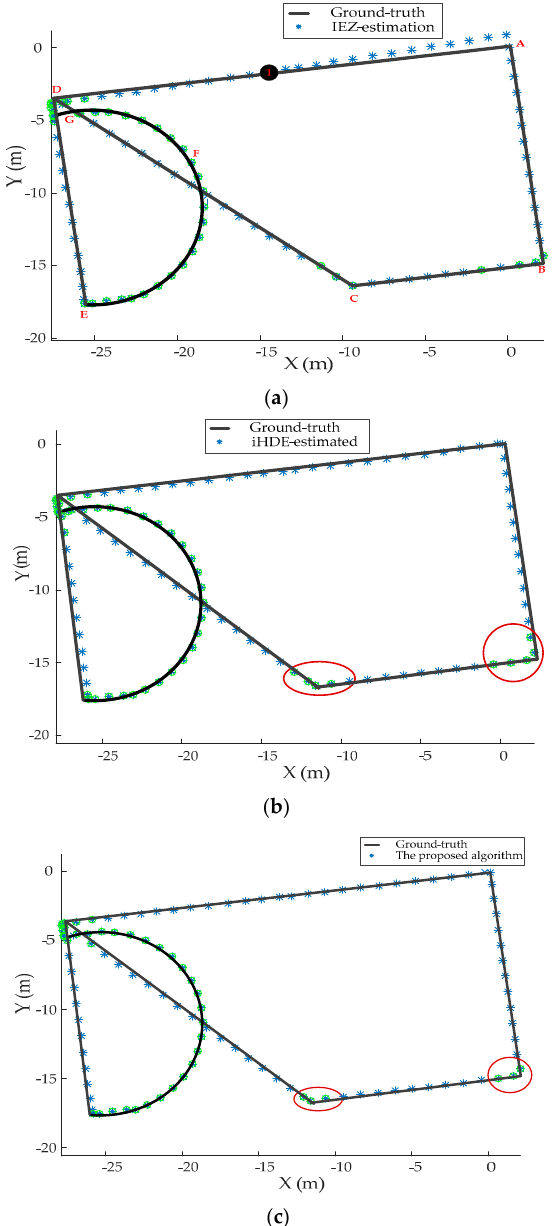
Figure 11. Evaluation of the algorithms. ( a ) Estimated trajectory using the IEZ algorithm. ( b ) Estimated trajectory using the iHDE algorithm. ( c ) Estimated trajectory using the proposed heading correction algorithm. The green circles represent the curved walking steps.